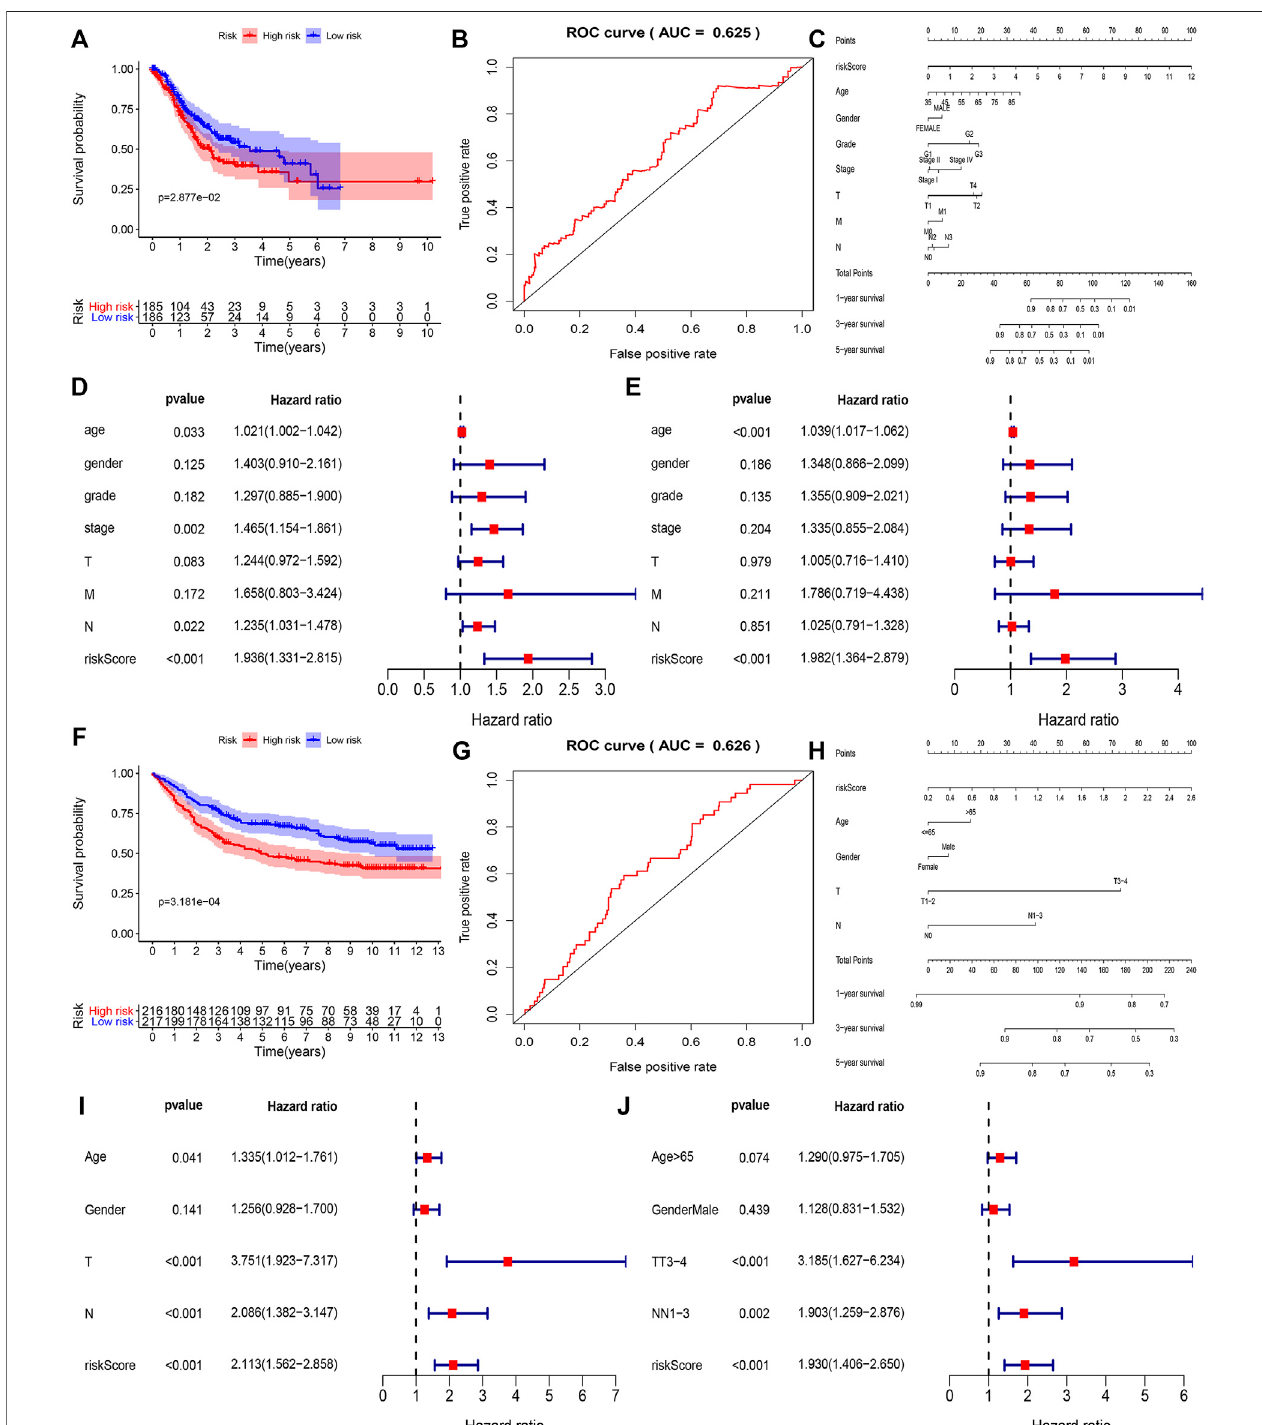
FIGURE 4 | The correlation between the construction of the prognostic model and the clinical characteristics of the selected genes in the TCGA and GEO databases. (A,B) BasedonCOXregressionanalysistoscreenouthigh-riskgenesinTCGA,ROCcurveshowingaccuracy(AUC=0.625)oftheclinicalprognosismodel. (C) Nomogram of TCGA risk score and clinical characteristics of gastric cancer patients. Each factor corresponds to its score, and each score is added to obtain a total score. (D,E) Single-factor COX regression analysisand multi-factor COX regressionanalysisofTCGA risk score. (F,G) Based on COX regression analysis aclinical prognostic model was constructed, and the ROC curve is used to detect the accuracy of the model (AUC = 0.625). (H) Nomogram of GSE84437 risk score and clinical characteristics of patients with gastric cancer. (I,J) Univariate Cox regression analysis and multivariate COX regression analysis of GEO risk score.